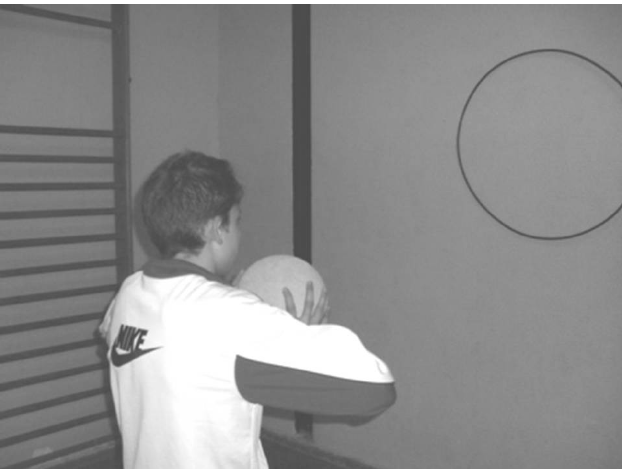
Figure 2. Eye-hand and eye-foot coordination test.